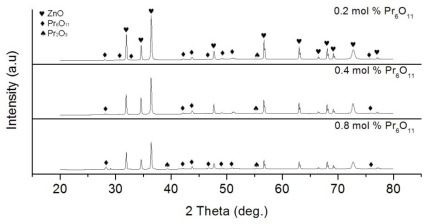
XRD patterns of sintered ZnO varistor ceramics with Pr6O11 content.